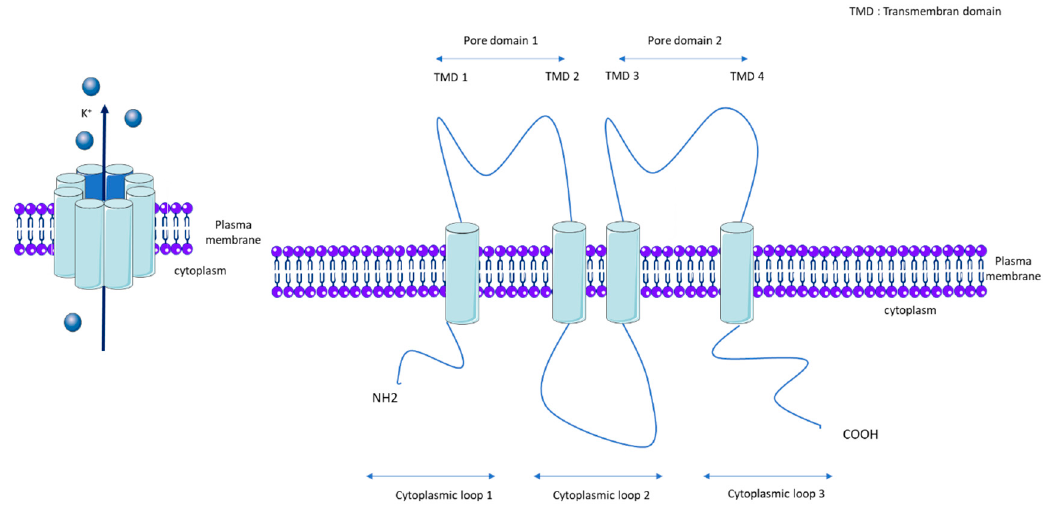
Figure 1. General molecular architecture of two pore potassium channels (K2P). TMD: Transmembrane domain.